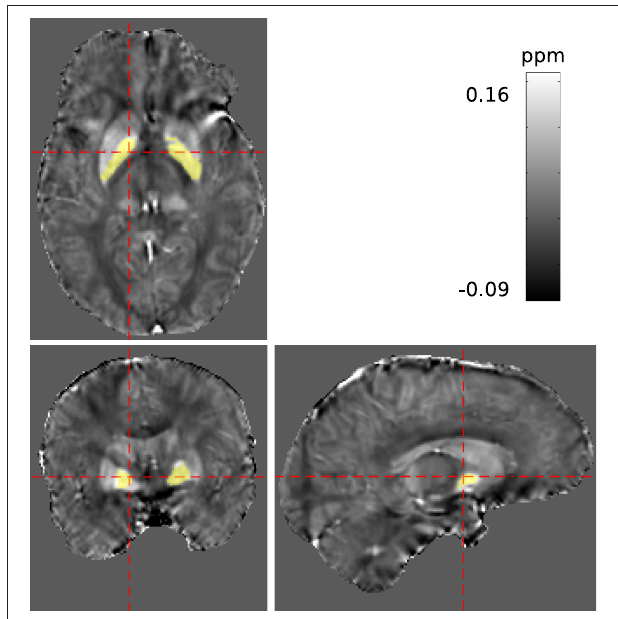
FIGURE 4 | Segmentation of a potentially homogeneous region within the pallidum (PAL) highlighted in yellow, displayed in the reconstructed susceptibility